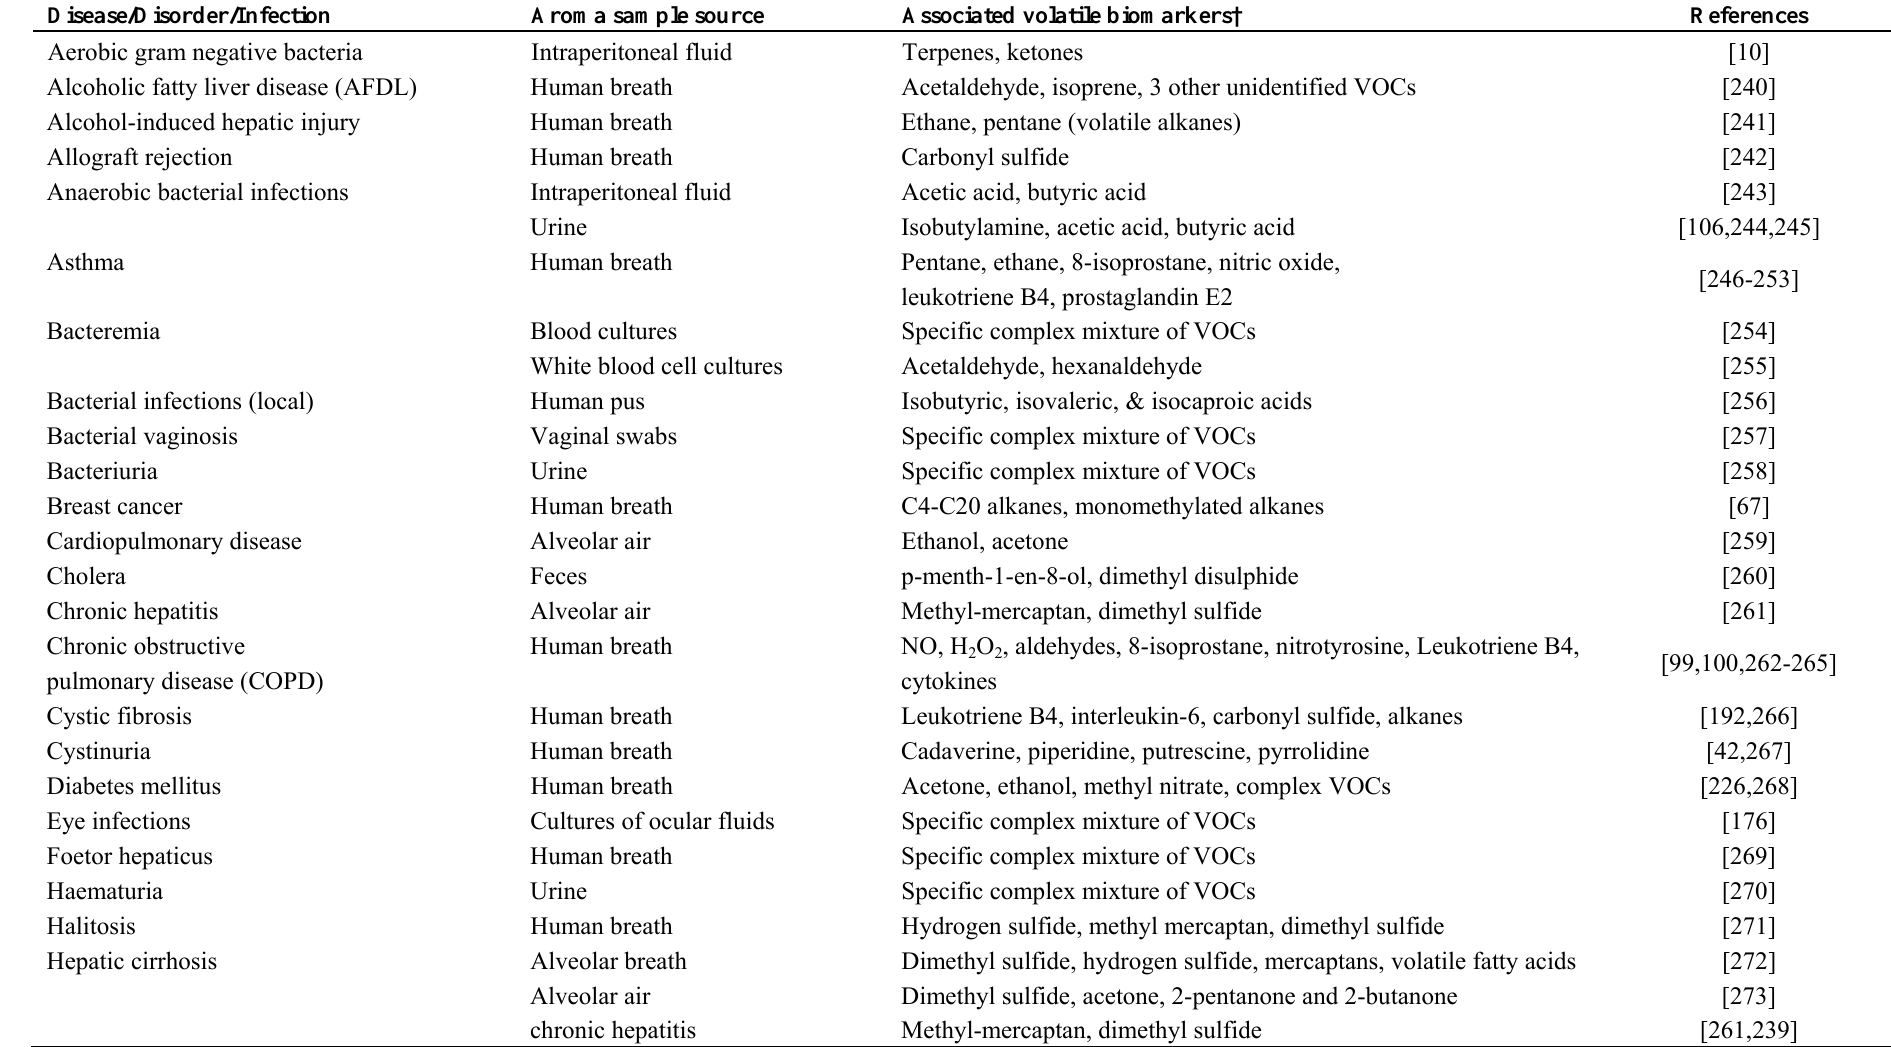
Table 3. Potential electronic-nose applications for human and animal disease diagnoses via detection of volatile biomarker indicator